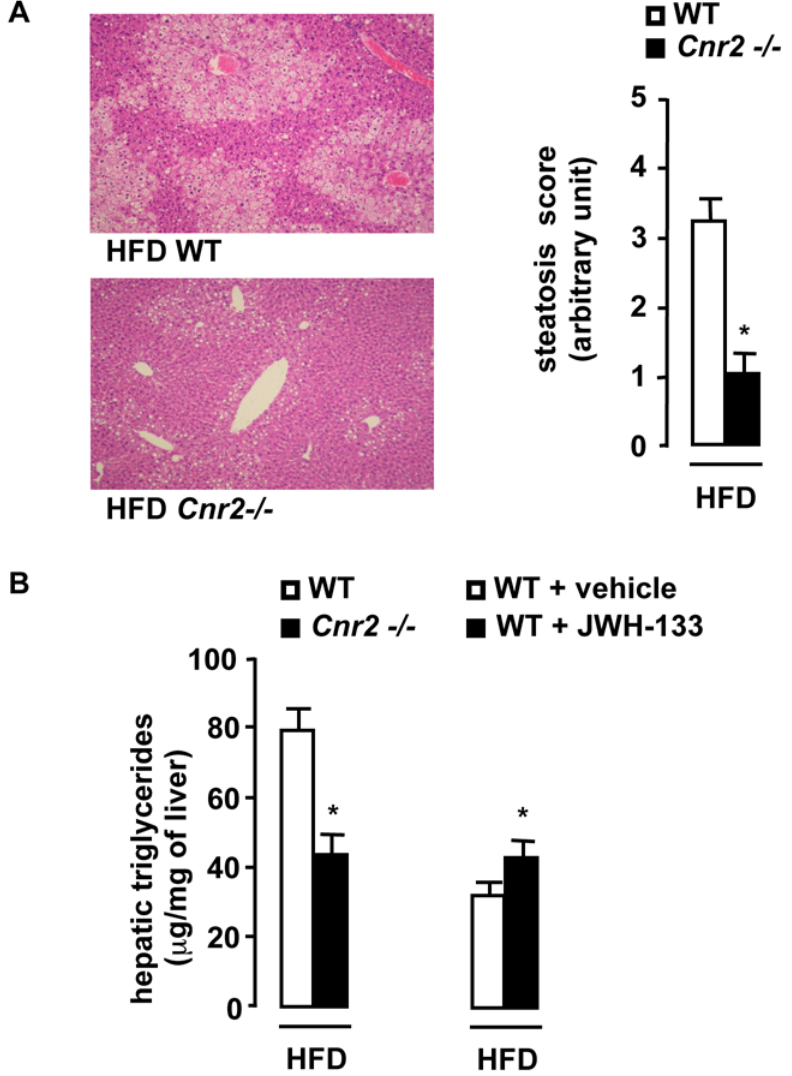
Figure 6. CB2 receptors promote the development of hepatic steatosis. A, Cnr2 knock-out blunts steatosis. Representative liver tissue sections (magnification 6 100), mean steatosis score and hepatic triglycerides in WT and Cnr2 2 / 2 mice fed a HFD for 15 weeks. B, Hepatic triglycerides in HFD-fed WT or Cnr2 2 / 2 mice for 15 weeks and in vehicle or JWH-133-treated (3 mg/kg) HFD-fed WT mice for 6 weeks. *p , 0.05 for JWH-133 vs vehicle or for HFD-fed Cnr2 2 / 2 vs HFD-fed WT mice.